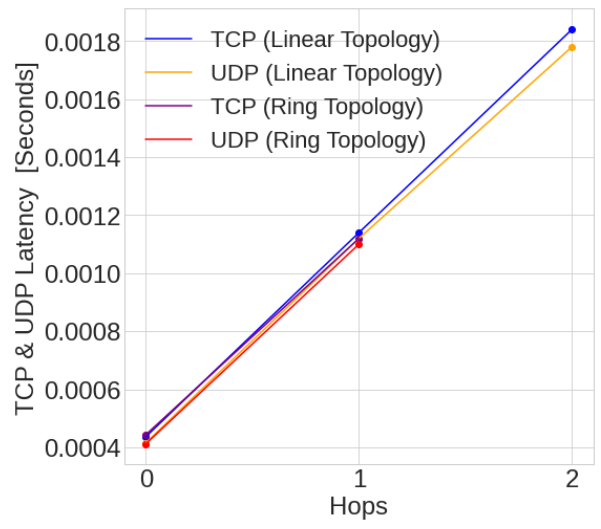
Figure 33. CityLab TCP and UDP latency.